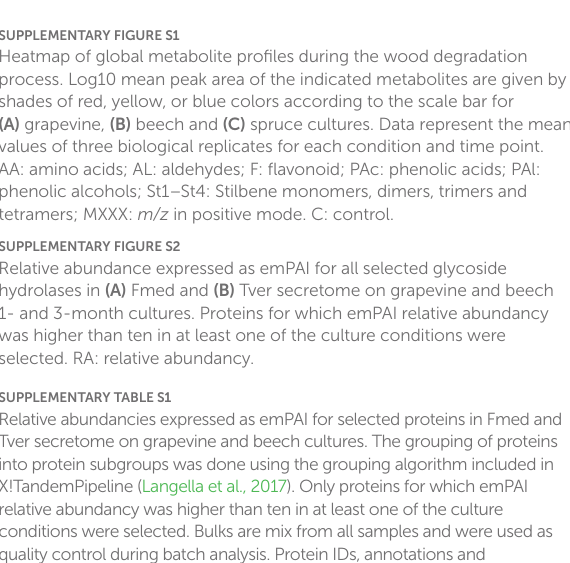
SUPPLEMENTARY FIGURE S1 Heatmap of global metabolite profiles during the wood degradation process. Log10 mean peak area of the indicated metabolites are given by shades of red, yellow, or blue colors according to the scale bar for (A) grapevine, (B) beech and (C) spruce cultures. Data represent the mean values of three biological replicates for each condition and time point. AA: amino acids; AL: aldehydes; F: flavonoid; PAc: phenolic acids; PAl: phenolic alcohols; St1–St4: Stilbene monomers, dimers, trimers and tetramers; MXXX: m/z in positive mode. C: control. SUPPLEMENTARY FIGURE S2 Relative abundance expressed as emPAI for all selected glycoside hydrolases in (A) Fmed and (B) Tver secretome on grapevine and beech 1- and 3-month cultures. Proteins for which emPAI relative abundancy was higher than ten in at least one of the culture conditions were selected. RA: relative abundancy. SUPPLEMENTARY TABLE S1 Relative abundancies expressed as emPAI for selected proteins in Fmed and Tver secretome on grapevine and beech cultures. The grouping of proteins into protein subgroups was done using the grouping algorithm included in X!TandemPipeline (Langella et al., 2017). Only proteins for which emPAI relative abundancy was higher than ten in at least one of the culture conditions were selected. Bulks are mix from all samples and were used as quality control during batch analysis. Protein IDs, annotations and classification are given according to JGI and Gene Ontology (GO)